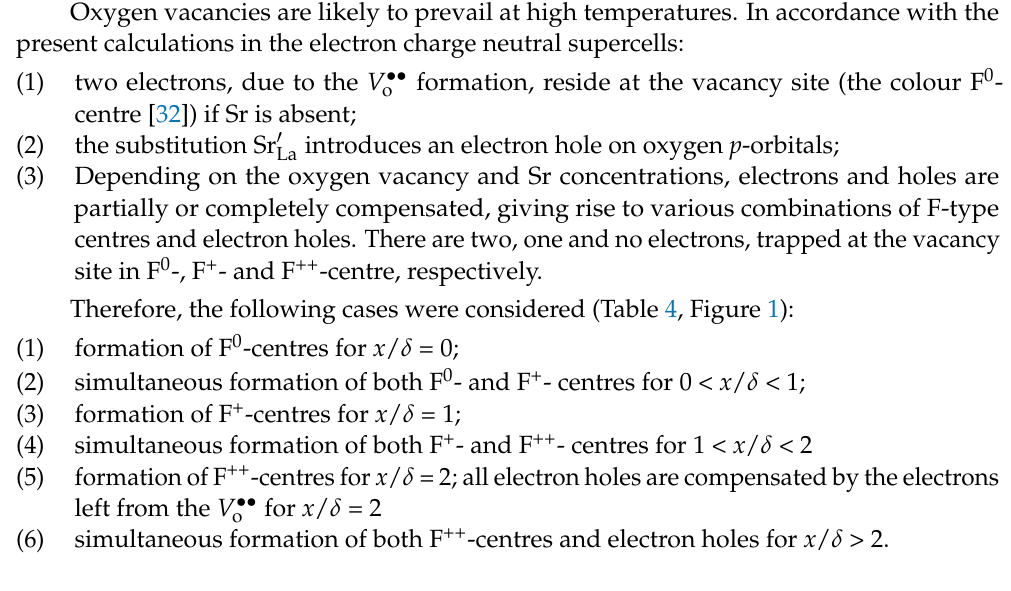
Table 4. Share of F-type centres and electron holes in La 1 − x Sr x ScO 3 − δ (Figure 1). x / δ